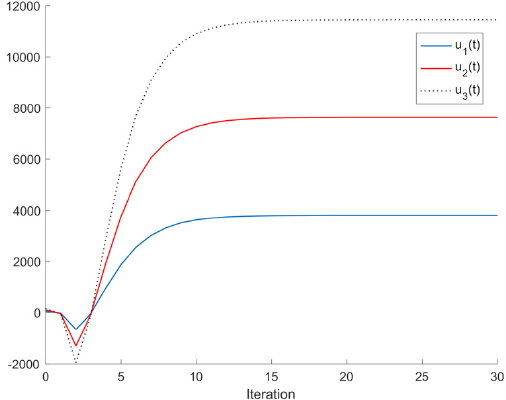
Figure 11. Values of the control signal u t in Example